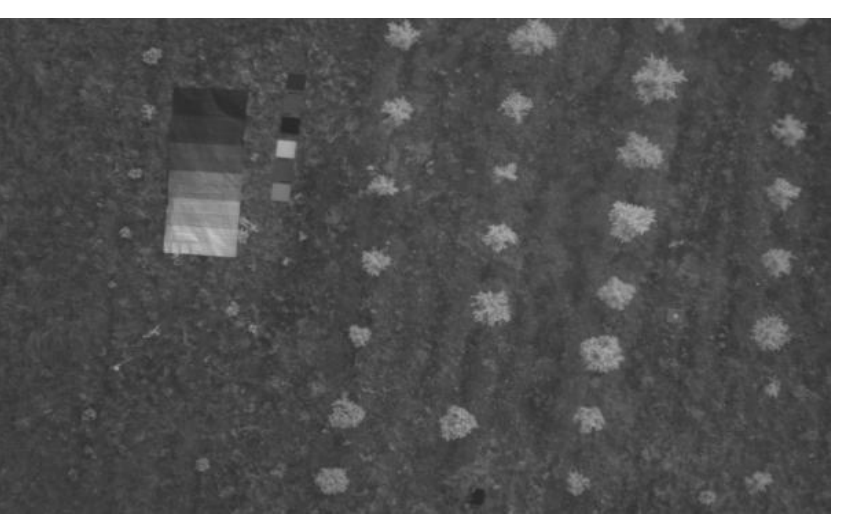
Figure 9. An example of a multispectral 10-bit image (sixth channel image, 801 nm).